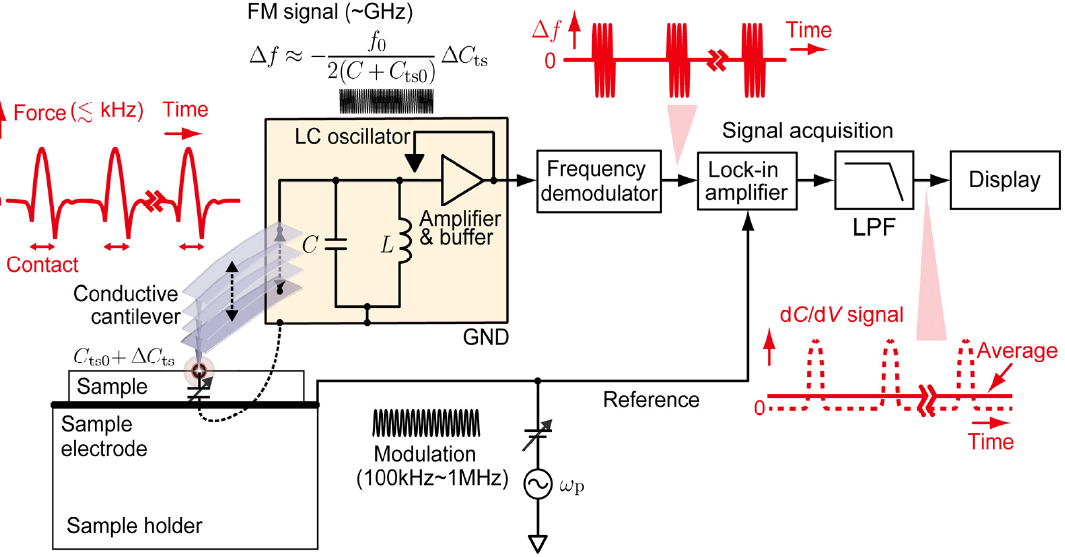
Figure 1. Schematic diagram of PFT-SNDM. The periodic contact of the tip with the sample surface generates a pulse train of frequency shift at the output of a frequency demodulator. The period and duty cycle of the pulse train are the same as those of the periodic contact. Because of the averaging effect on the pulse train in the signal acquisition, the signal intensity can significantly decrease. C-